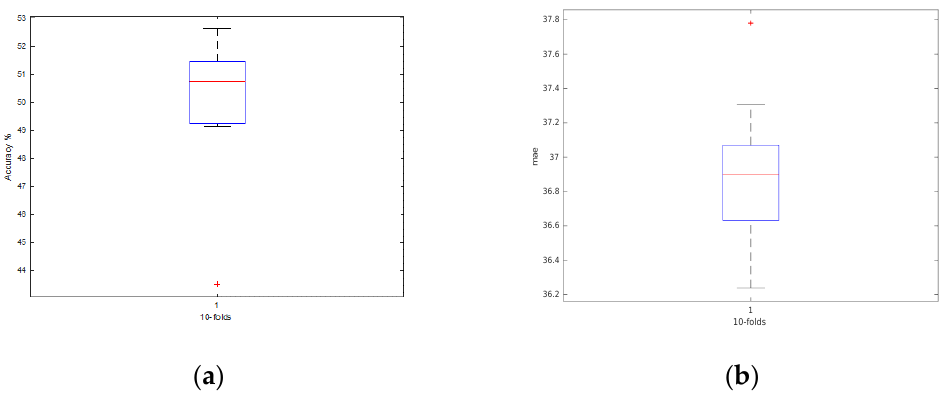
Figure 2. Falling precision with the 10-cross valuation; ( a ) AEC accuracy; ( b ) AEC MAE.